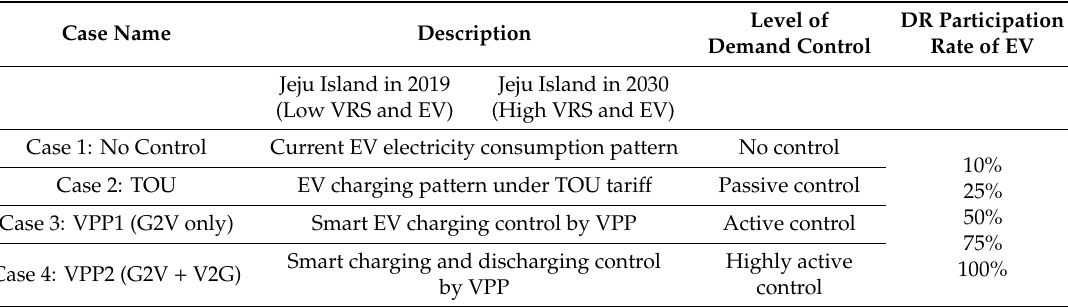
Table 2. Structure of the